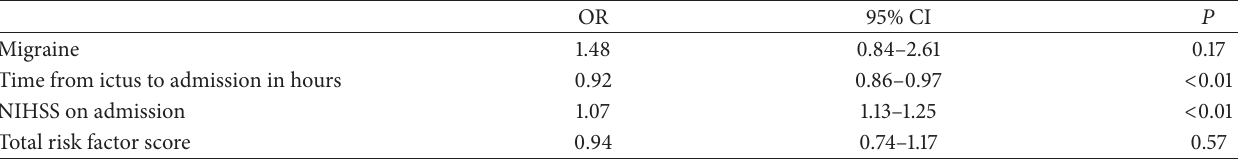
Table 4: Logistic regression analysis displaying factors associated with thrombolytic therapy (tPA) in AIS patients admitted within the thrombolytic time window between 50 and 80 years of